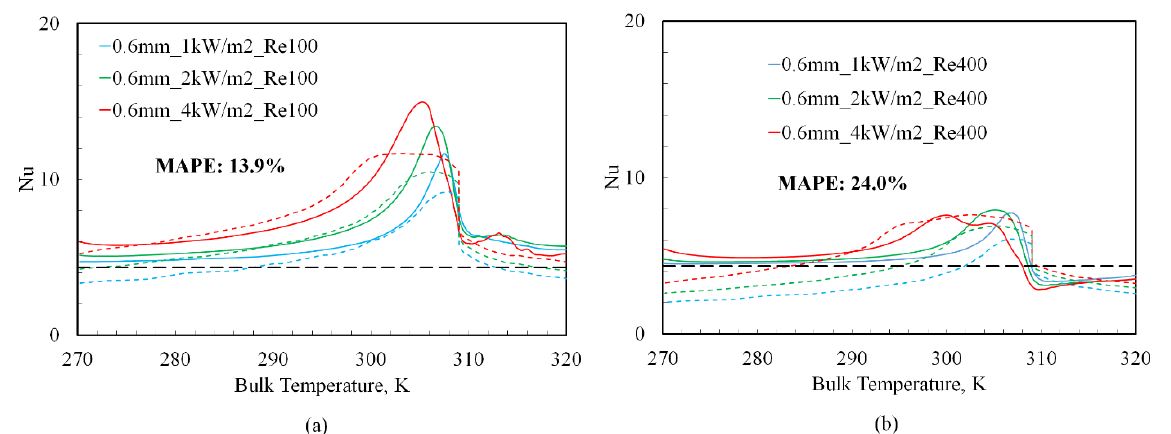
Figure 10. Equation (11) based predictions of Nu (dotted lines) versus bulk temperature (T BULK ) at a tube diameter of 0.6 mm and different inlet Re: ( a ) 0.6 mm, Re 100; ( b ) 0.6 mm, Re 400. The values of B in Equation (10) w ere: 0.37 for T BULK < T PC and 0.30 for T BULK > T PC.